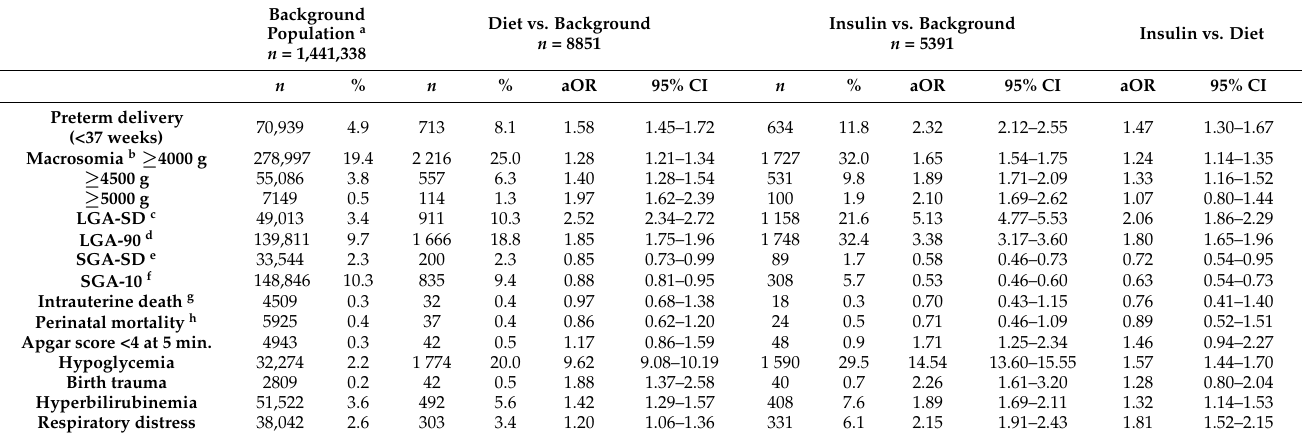
Table 3. Neonatal outcomes in singleton pregnancies diagnosed with diet- or insulin-treated GDM.